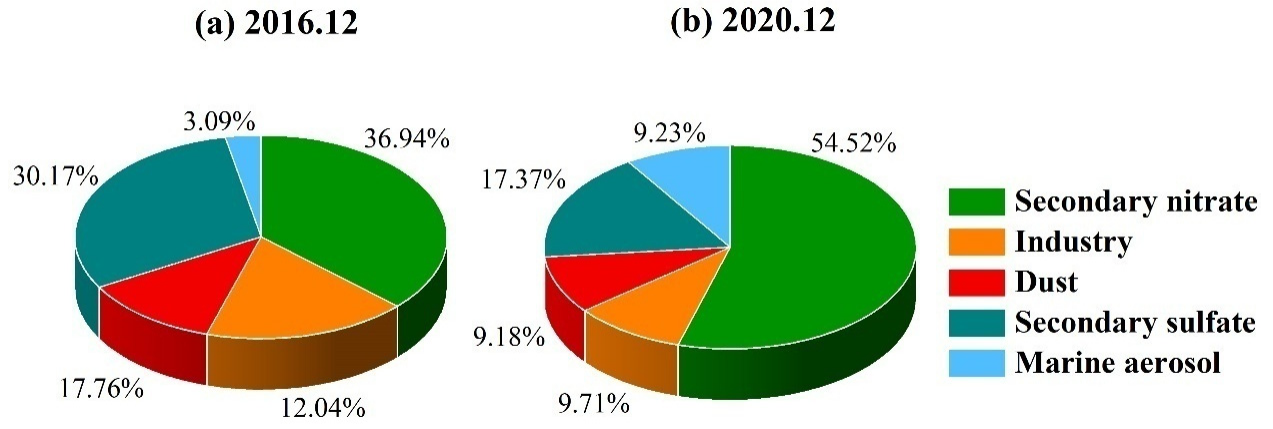
Figure 8. Contributions of sources of WSIIs in Nanjing in December of different years: ( a ) December 2016; ( b ) December